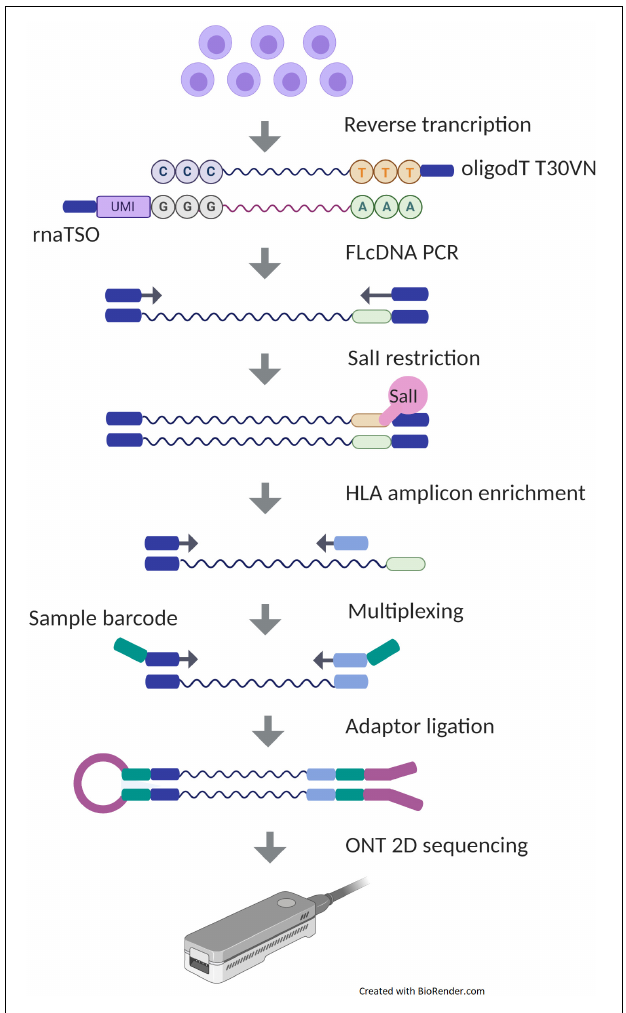
FIGURE 1 | Experimental design of Oxford Nanopore Technologies (ONT) platform. In the sequencing library preparation of ONT, messenger RNA (mRNA) is first reverse transcribed into complementary DNA (cDNA) using an oligodT T30VN primer capturing a polyA tail of mRNA, with simultaneous integration of 10 bp unique molecular identifier (UMI) in RNA template-switching oligonucleotide (rnaTSO), and further amplified using polymerase chain reaction (PCR). The full-length cDNA (FLcDNA) is then processed with Sal I restriction enzyme followed by an enrichment of HLA genes and adding sample-specific barcodes for multiplexing. Libraries are ligated with ONT adaptors and sequenced on a MinION sequencer.